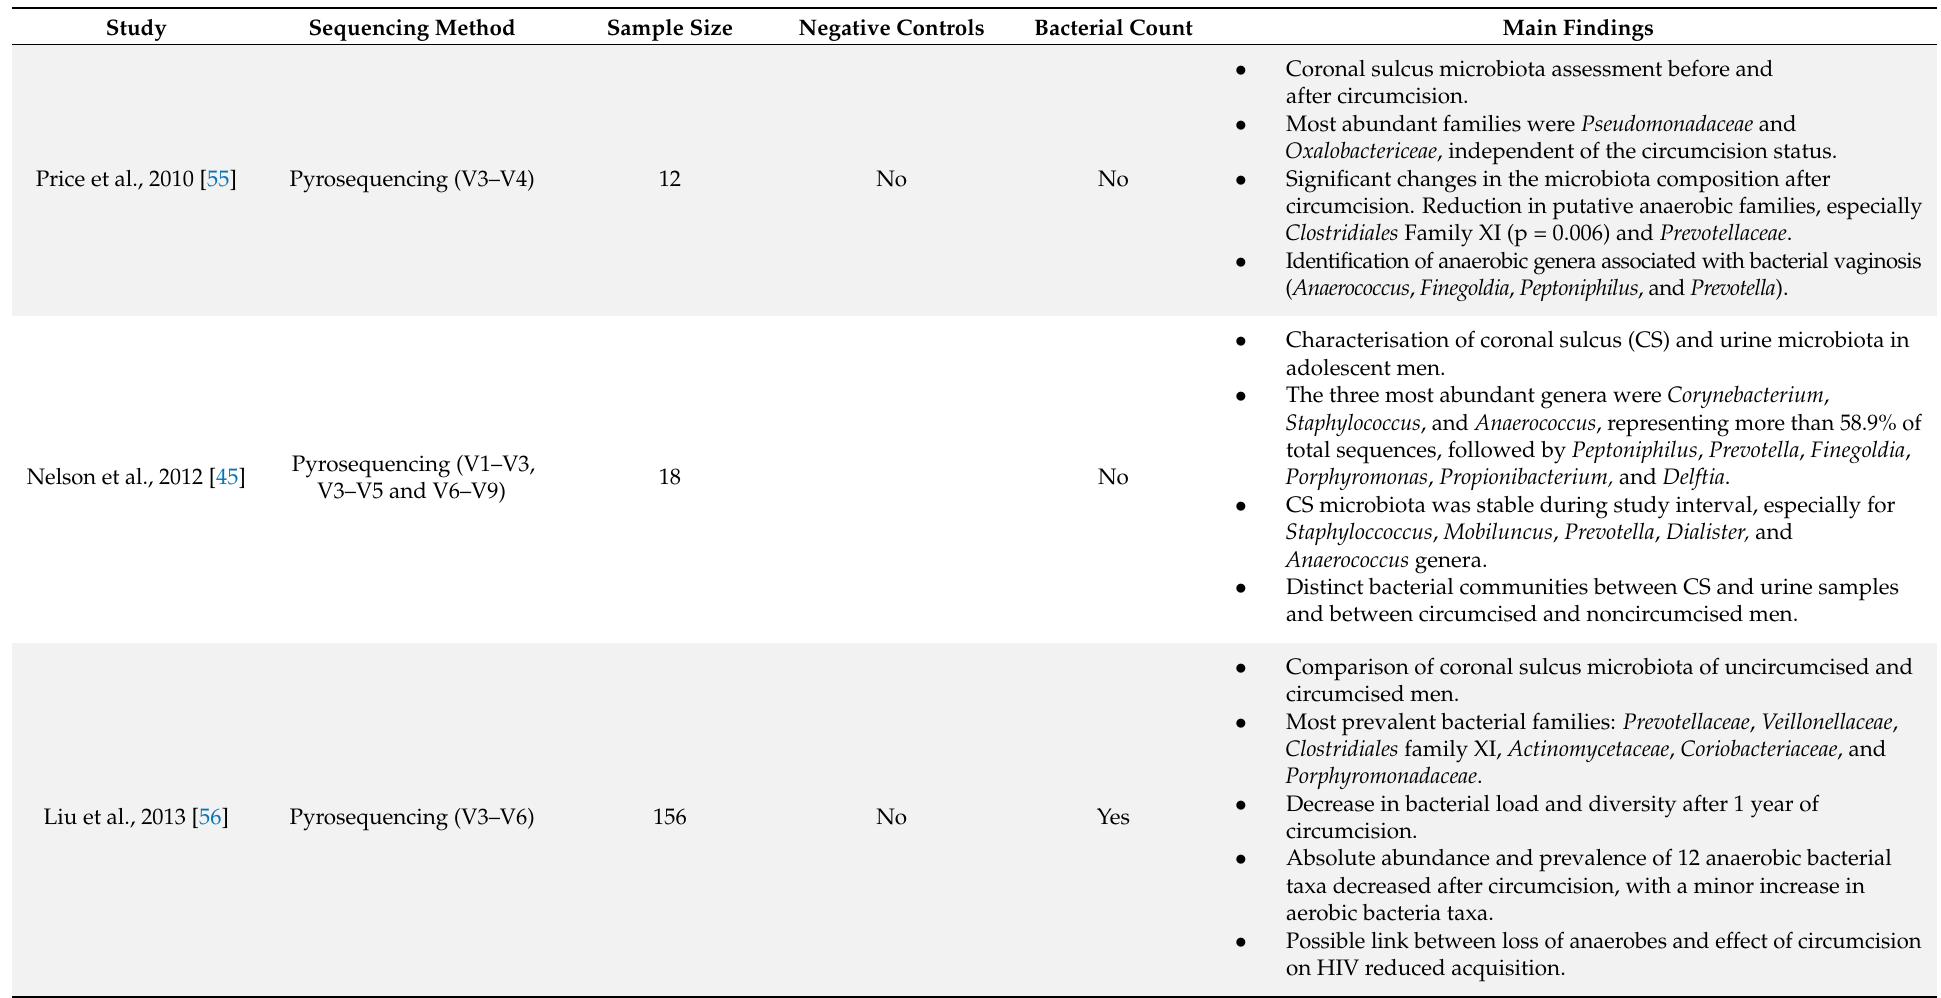
Table 2. Characterisation of penile microbial communities using